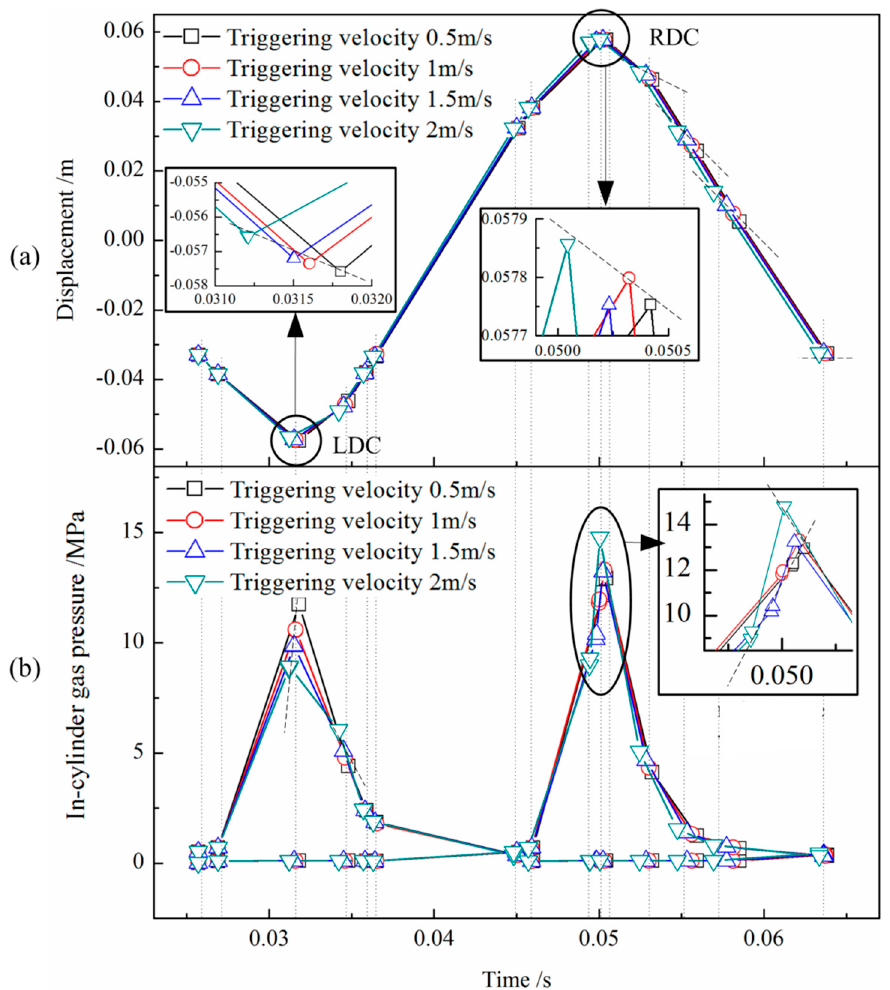
Figure 12. Cycle feature points at the same “triggering velocity”. ( a ) Displacement; ( b ) In-cylinder gas